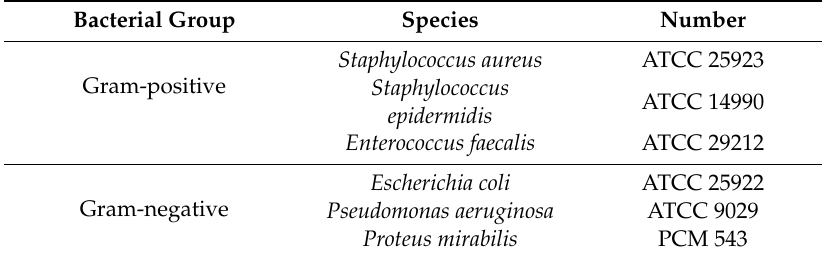
Table 2. Reference bacterial